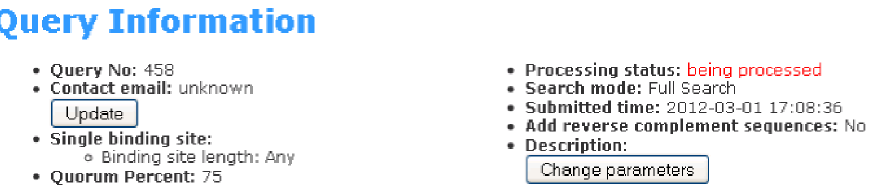
Figure 2. Query information. Information about submission. Users can click on the ‘‘Update’’ button or the ‘‘Change parameters’’ button to update the contact email or change parameters.